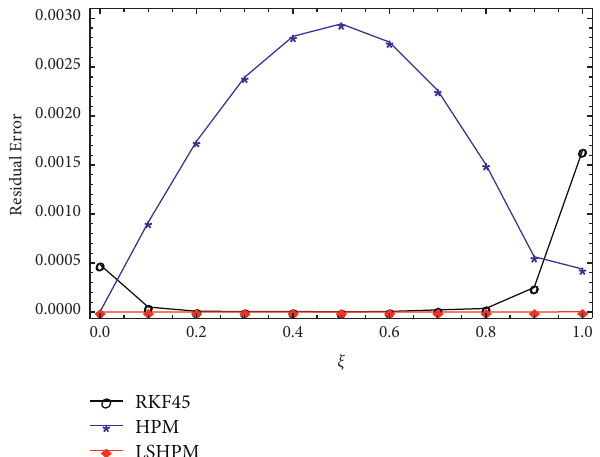
Figure 4: Comparison of errors for RKF45, HPM, and LSHPM when R � 0 . 3 ,M